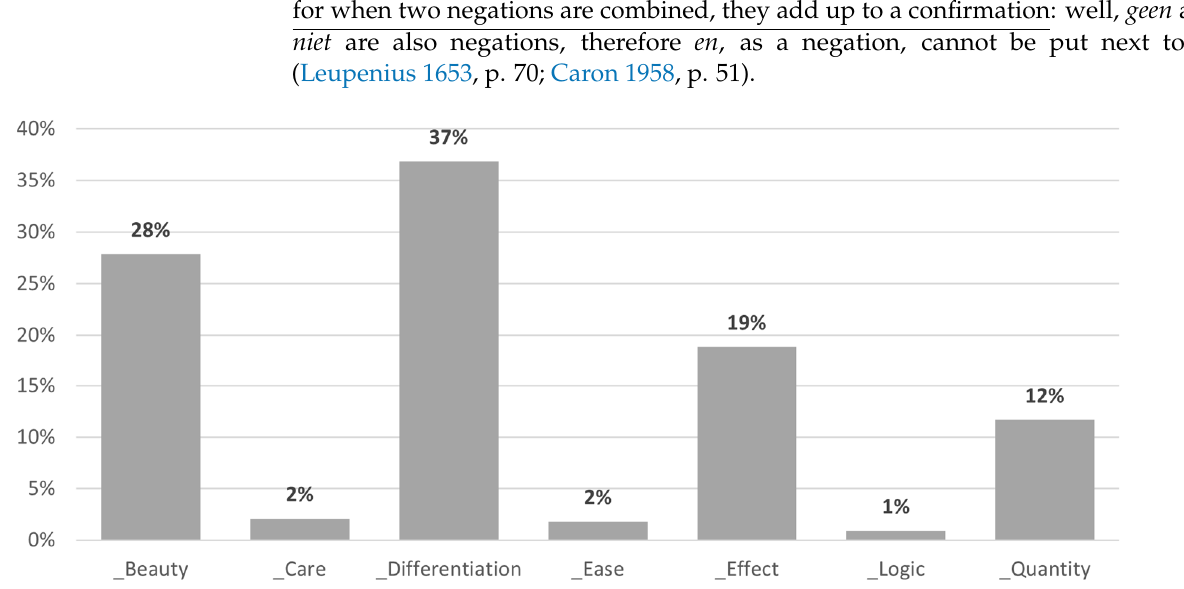
Figure 6. Relative frequency of the lower-level categories within the top-level category Q UALITY (% of total number of Q UALITY arguments, n = 334).